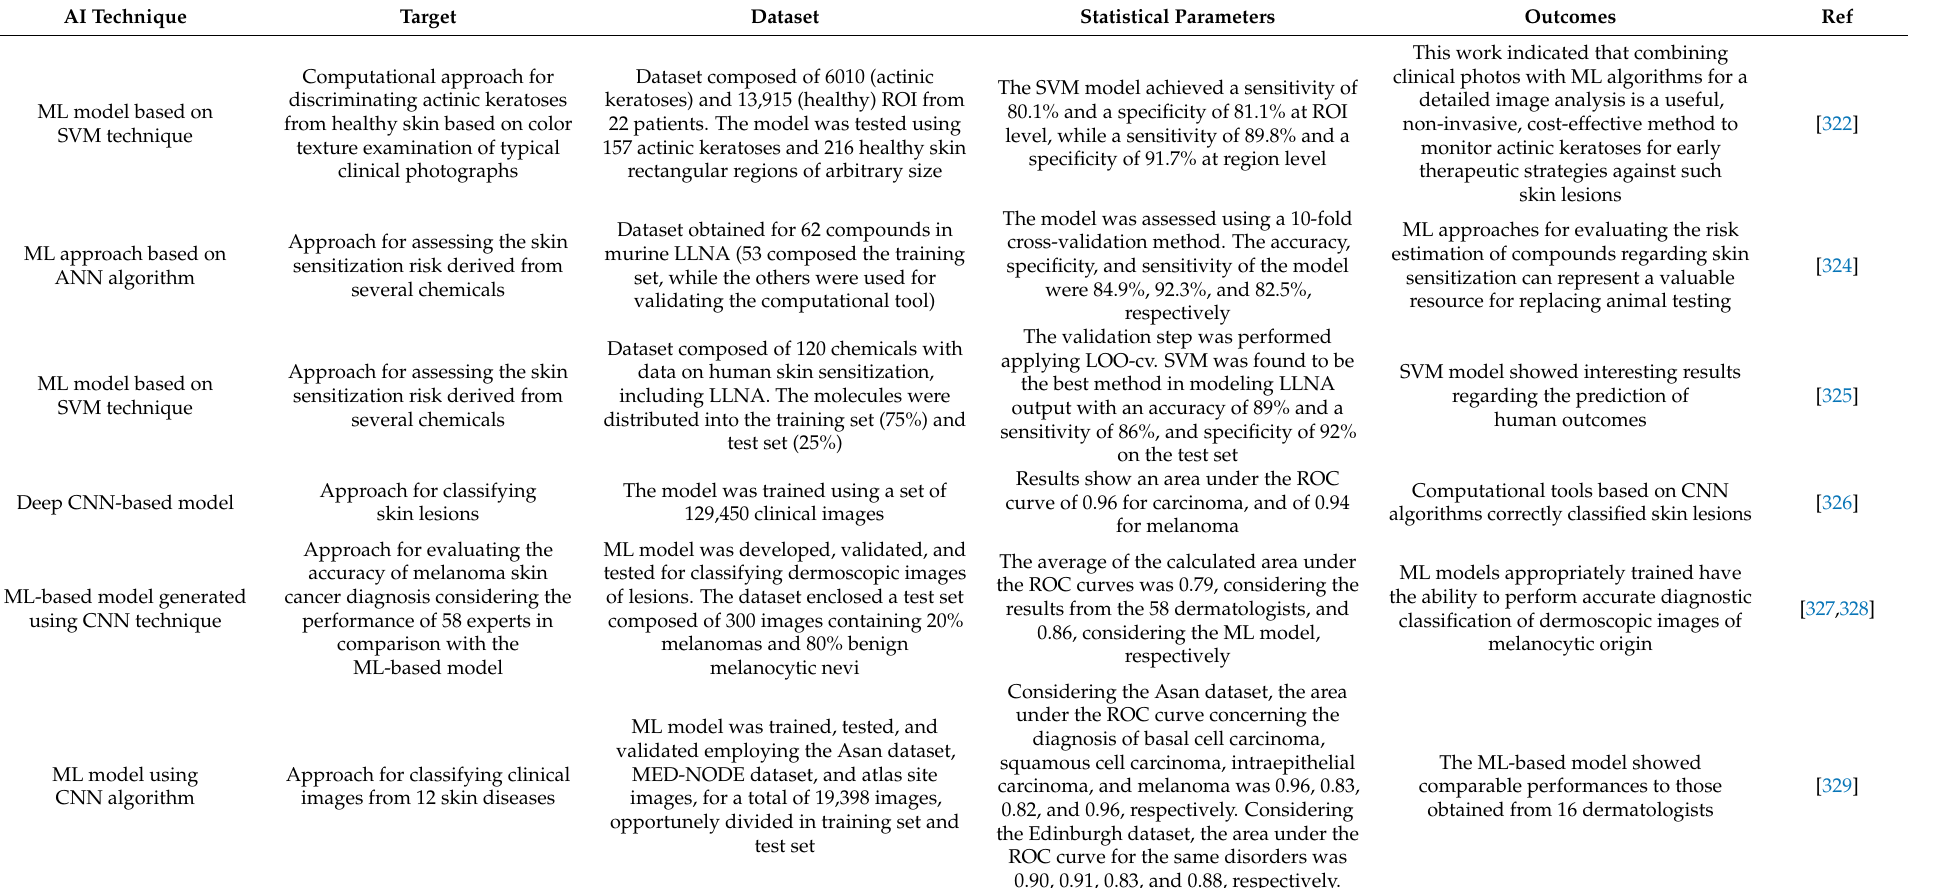
Table 9. Main examples of AI/ML in